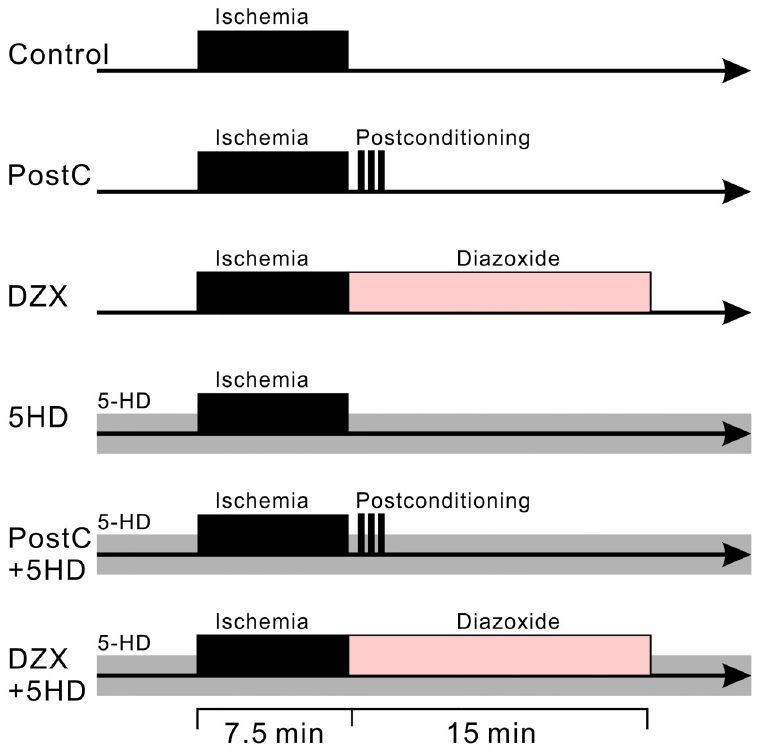
Fig 1. Diagrams representing the perfusion protocol for experimental groups. Ischemic perfusion is shown as a black band. Gray and faded-pink bands indicate administration of 5-HD and diazoxide to the bath solution, respectively. Electrophysiological recordings started 5 min before the ischemic perfusion and lasted up to 20 min after the reperfusion.